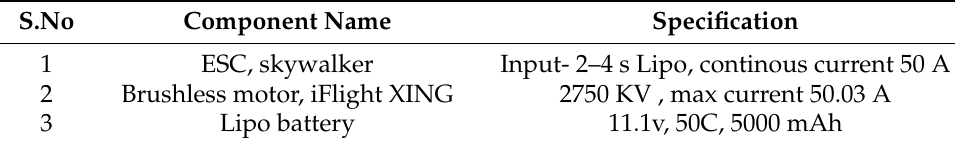
Table 2. Details of electronics component for vacuum